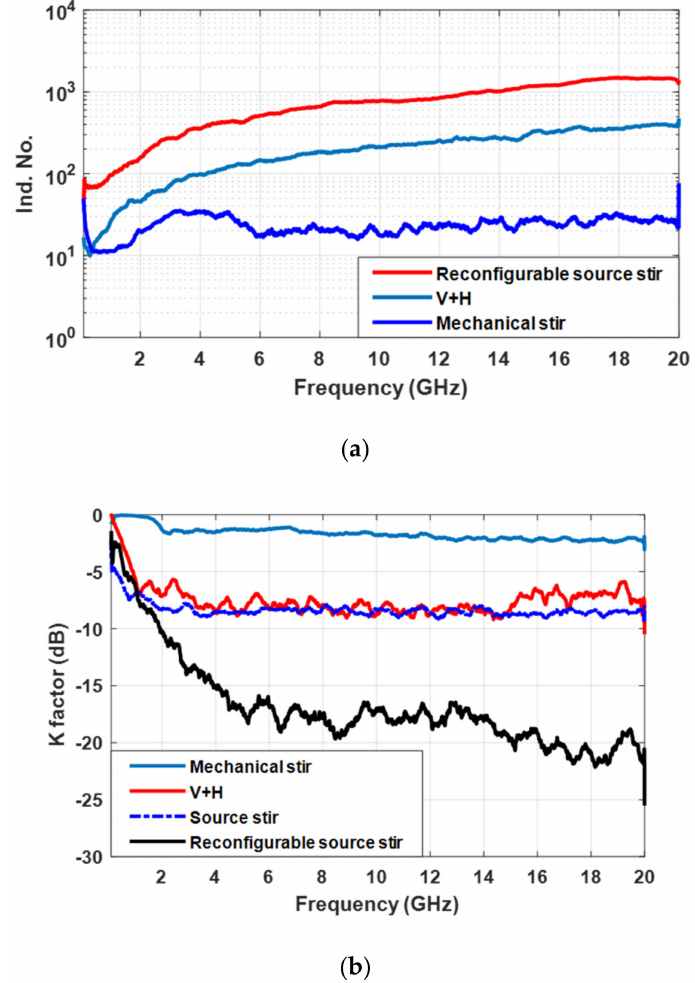
Figure 4. ( a ) Independent sample numbers; ( b ) Averaged K